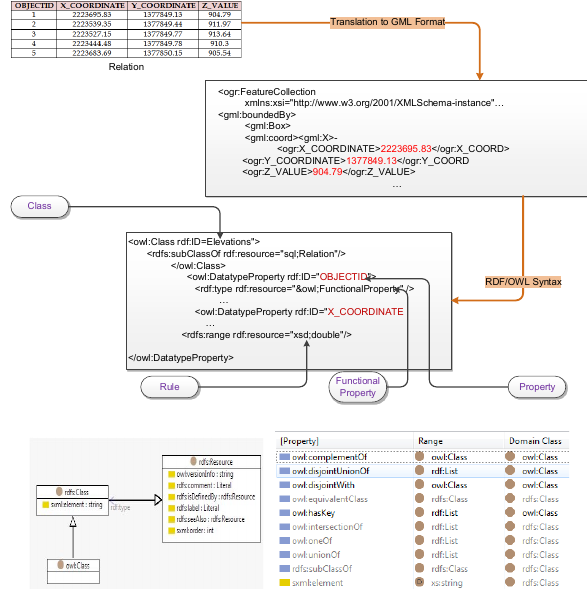
Figure 11. RDF graph of CityGML (top), rdf:Class and subclass Owl:Class, RDF schema rules (bottom left & right).